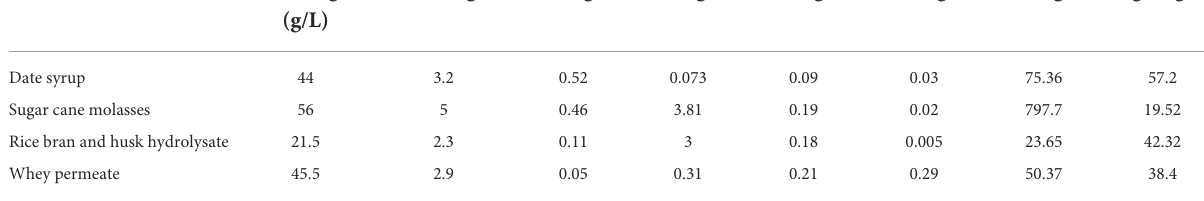
TABLE 1 Chemical composition of the substrates used in the present study.